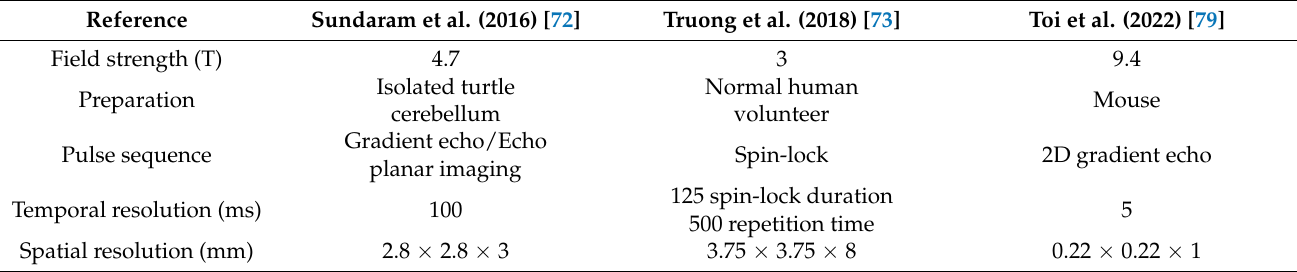
Table 1. Comparison of three experiments to measure neural currents using